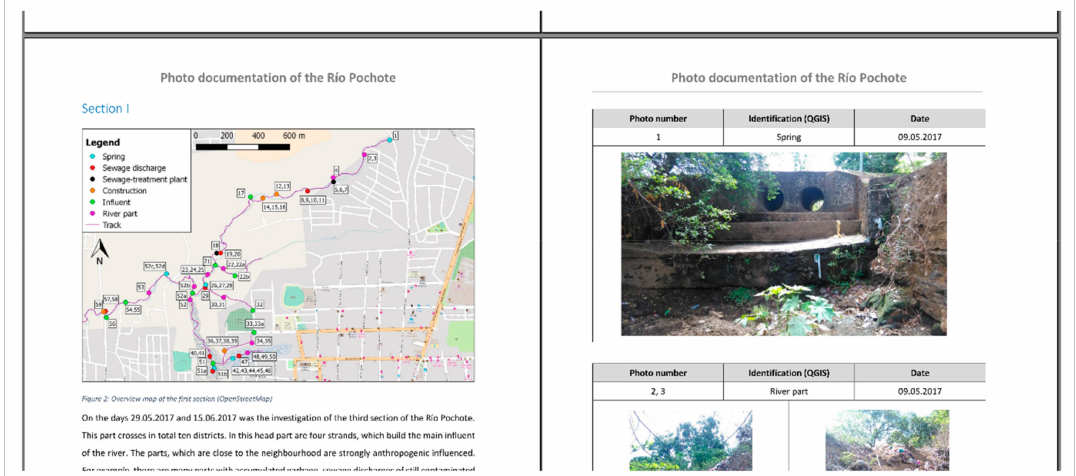
Figure A1. Cutout of a photo documentation of the Pochote River